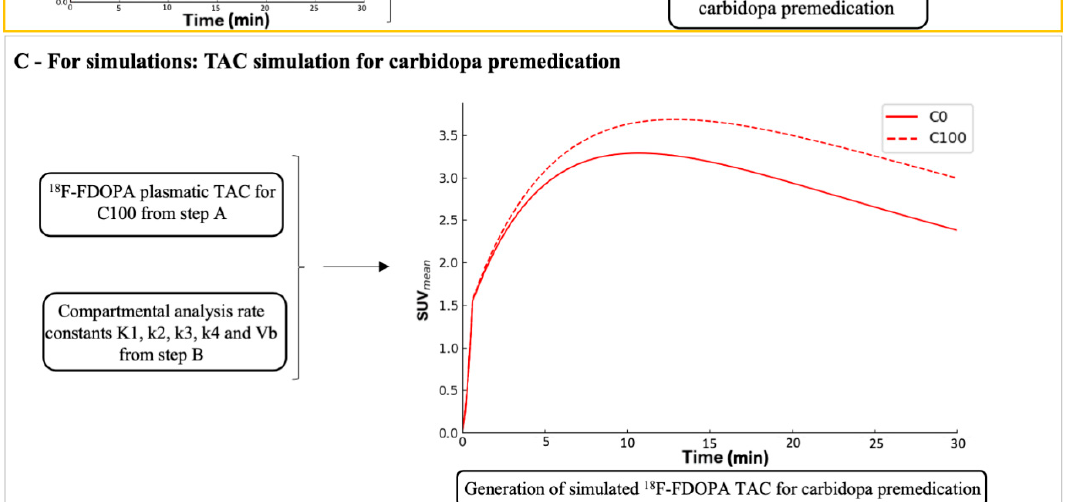
Figure 1. Generation of simulated time-activity curves simulating carbidopa premedication in the tumor volumes of interest (VOIs). The same processes were applied to healthy brain VOIs. ( A ) For C0 patients: input function pre-processing; ( B ) For C0 patients: parameter extractions; ( C ) For simulations: TAC simulation for carbidopa premedication.